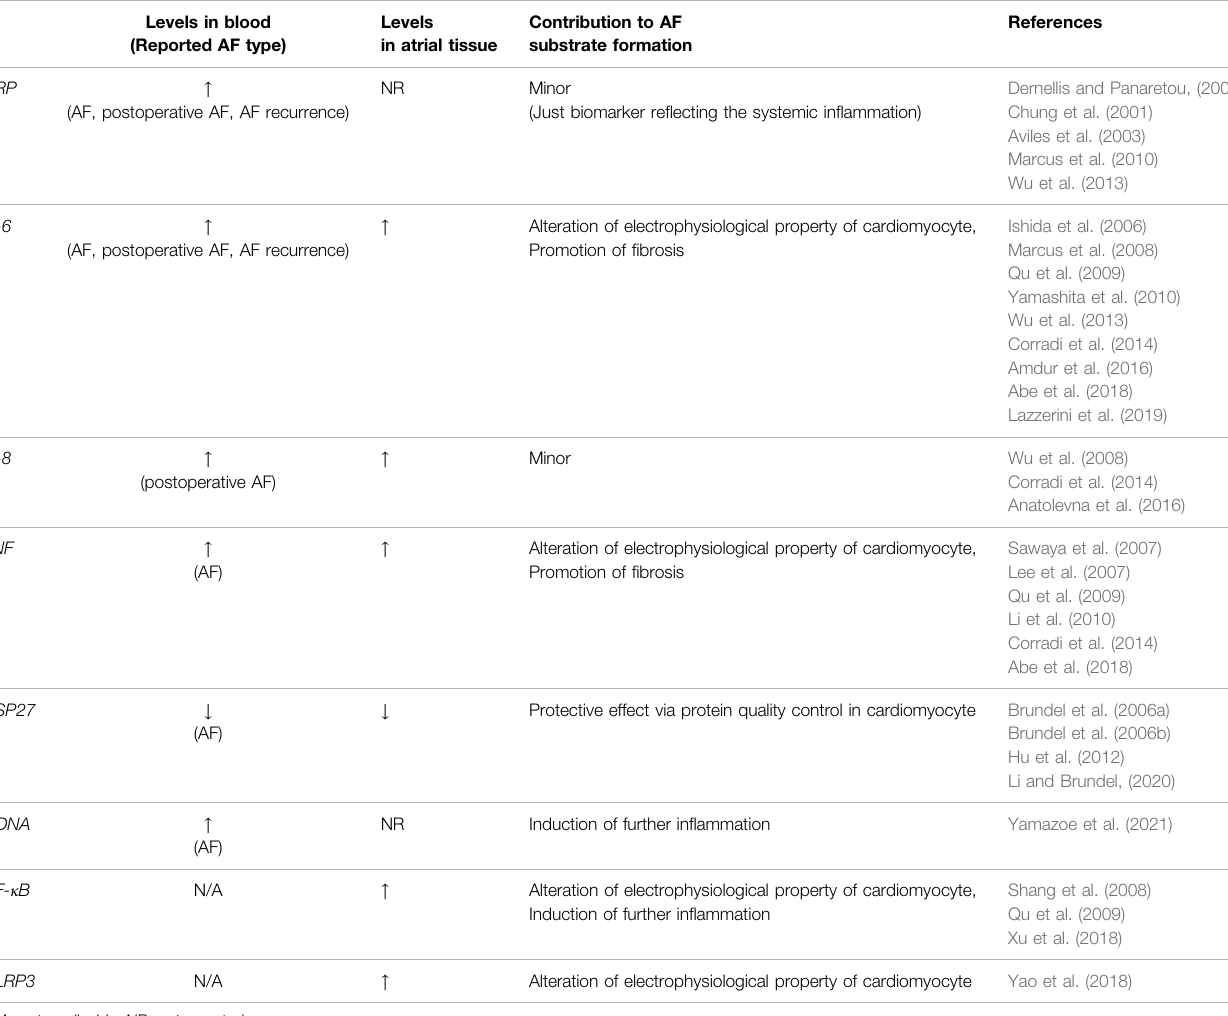
TABLE 1 | Summary of the main in fl ammatory molecules in AF